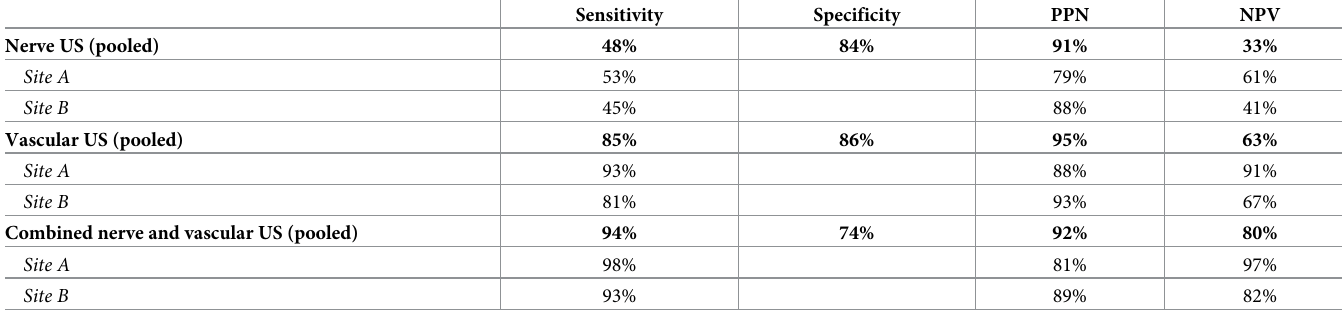
Table 3. Sensitivity, specificity, positive predictive values and negative predictive values of ultrasonographic findings in